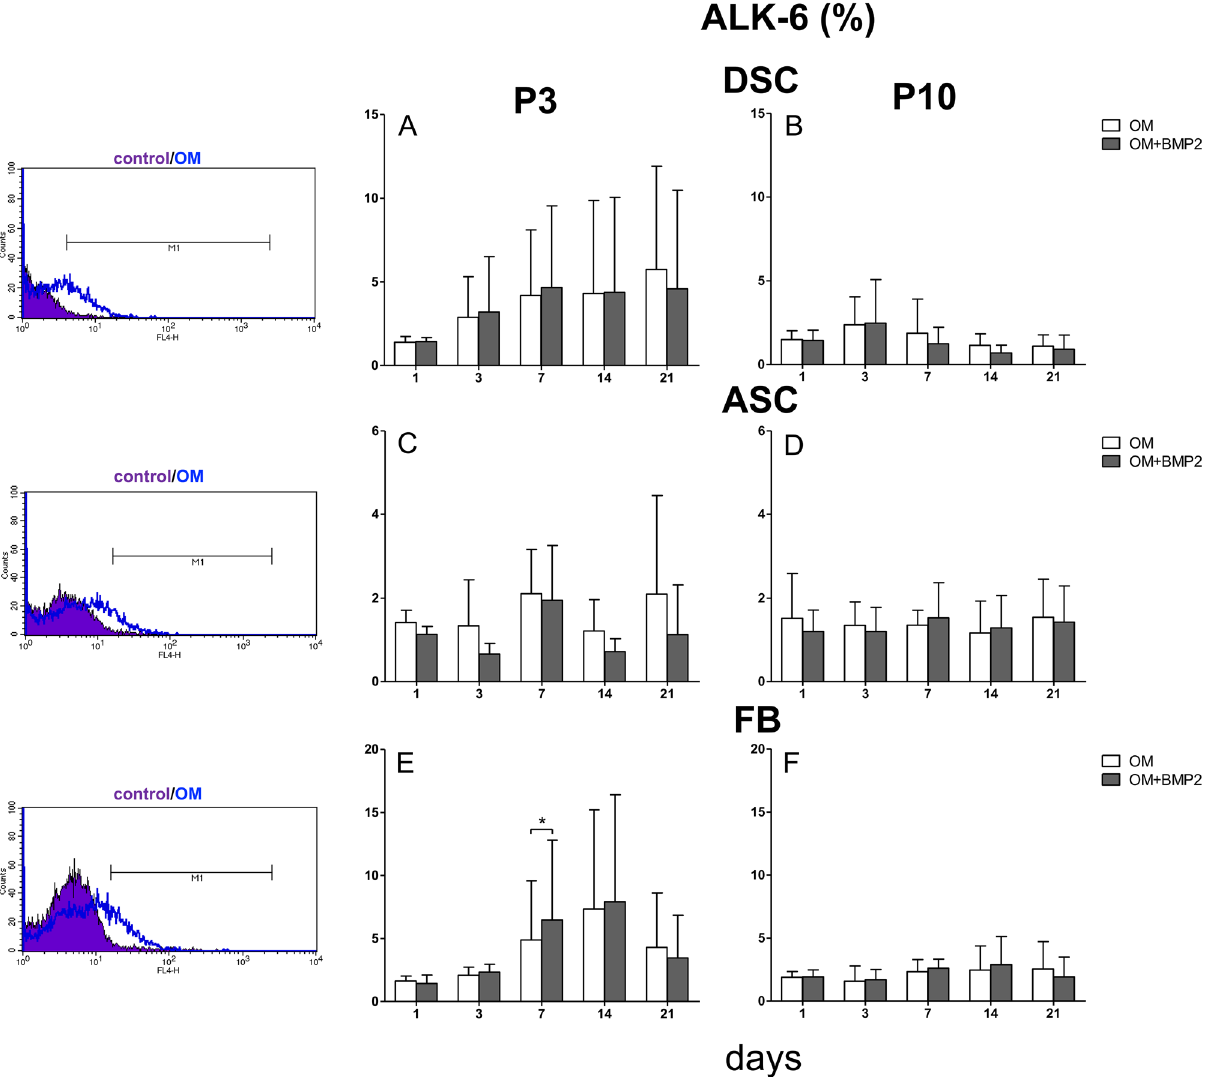
Figure 4. ALK-6 expression in P3 versus culture senescence cells at P10. ( A ) Evaluated was the ALK-6 expression in DSC at P3. Expression of ALK-6 increased over the course of osteogenic differentiation. ( B ) Evaluated was the ALK-6 expression in DSC at P10. ( C ) Evaluated was the ALK-6 expression in ASC at P3. ( D ) Evaluated was the ALK-6 expression in ASC in P10. ALK-6 was expressed at a small amount. ( E ) Evaluated was the ALK-6 expression in FB in P3. The expression increased weakly between day 7 and 14. On day 7 was a significant difference between the BMP-2 treatment and the standard osteogenic differentiation in favor to the BMP-2 supplementation. ( F ) Evaluated was the ALK-6 expression in FB at P10. Grey bars represent these cells incubated with osteogenic differentiation media supplemented with BMP-2 (OM + BMP2). White bars represent cells differentiated with standard osteogenic differentiation media (OM). Bars represent mean ± SD of three donors. * p < 0.05 as compared to the respective sample treated with Interestingly, in FB (P3 and P10), the osteogenic differentiation potential was significantly increased by the simultaneous use of BMP-2 with the BMP signaling inhibitor dorsomorphin compared to treatment with dor- somorphin alone (Fig. 7). Moreover, in FB at P10, the inhibition of BMP signaling with the simultaneous use of BMP-2 was superior to all other applications. Evaluation of senescence associated β-galactosidase activity. DSC, ASC and FB at P3 demon- strated a comparable level of β-galactosidase activity visualized in faint blue (Fig. 8). Control cells at P3 treated with etoposide displayed comparable more β-galactosidase. Effects of senescence. At P10 DSC and FB exhibited the strongest β-galactosidase activity visualized in blue, in contrast to ASC, which showed a noticeably weaker staining (Fig. 8). Respective β-galactosidase protein